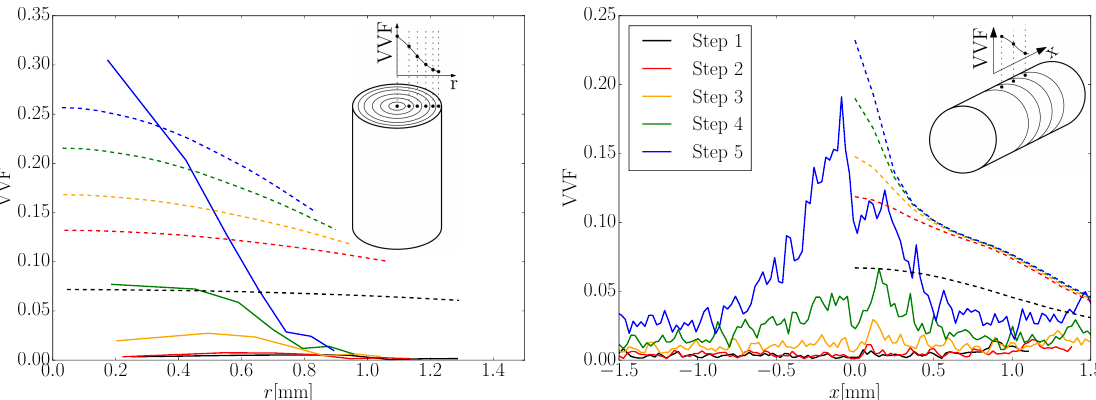
Figure 15. Radial ( left ) and longitudinal ( right ) voids distribution experimentally (continuous lines) and numerically (dashed lines) obtained for Material 1.